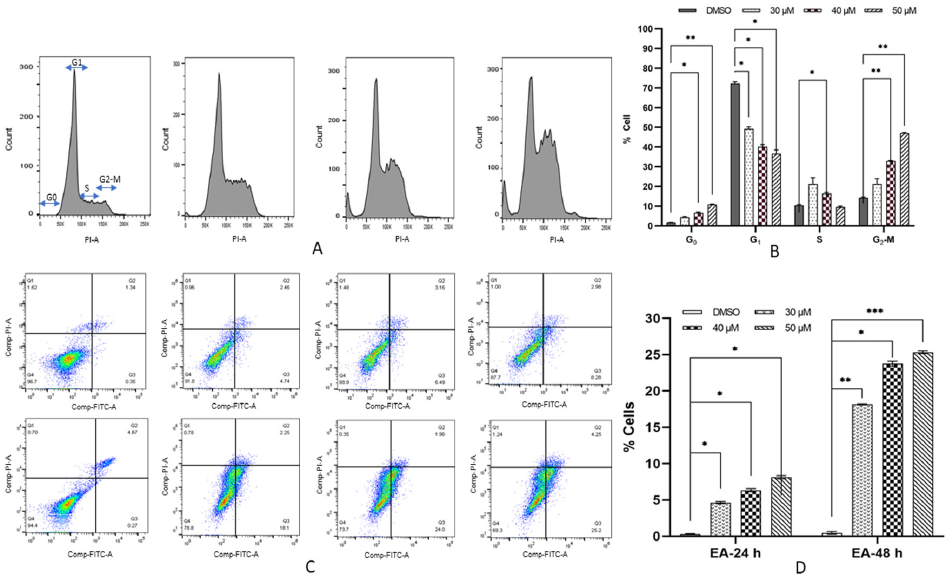
Figure 2. ( A ) Flow cytometry analysis: Analysis of DNA content of PI stained HeLa cells, treated with 30, 40 and 50 µM of kaempferol for 24 and 48 h, was compared with DMSO, which induced G2/M arrest cell cycle arrest with an increase in the sub-G0 apoptotic population. ( B ) Graphical rep- resentation of the cells’ distribution in different phases of the cell cycle at 48 h is expressed as a percentage. ( C ) Annexin V/PI double staining kaempferol-induced apoptosis in HeLa cells after treatment (30µM, 40µM and 50 µM) for 24 and 48 h in comparison with DMSO control. Representa- tive picture of dot plots showing different stages of apoptosis. Left lower quadrant (FITC-/PI-) = Viable cells, right lower quadrant (FITC+/PI-) = early apoptotic cells and right upper quadrant (FITC+/PI+) = late apoptotic cells. (D) Graph demonstrating % distribution of apoptotic cells in their respective quadrants. Early apoptotic cells proportions were increased at both time- and concentra- tion-dependent manner compared to control. * represents p < 0.05; ** = p < 0.01, *** p < 0.001. 3.4. Kaempferol Increases Early Apoptosis in HeLa Cells To ascertain whether G2/M cell cycle arrest is accompanied by apoptosis induction by kaempferol, Annexin V/PI double staining was employed. Treated HeLa cells at 20, 30 and 50 µM for 48 h exhibited an increase in the proportion of early apoptotic cells with an insignificant change in the proportion of post apoptotic cells. In contrast, the percentage of live cells showed a decreasing trend. Early apoptotic cell population was found to be increased from 0.35% to 4.74%, 6.49% and 8.26% at 30, 40 and 50 µM in 24 h, whereas in 48 h treatment, it raised to 18.1%, 24% and 25.2%, respectively. Therefore, Annexin/PI staining clearly established the apoptosis-inducing property of kaempferol in HeLa cells (Figure 2C,D). 3.5. Kaempferol Modulates Expression of Various Genes Involved in Cell Cycle Regulation and Signalling Pathways Overexpression of MAPK and AKT/mTOR leads to uncontrolled cell proliferation and survival, consequently causing transformation of cells. Kaempferol treatment (30 and 50 µM for 48 h) limits cancer cell proliferation by downregulating MAPK and AKT/mTOR pathways at the transcript level . Expression of various MAPK pathway genes was consid- erably downregulated, such as MAPK1, MAK14, MAP2K1, MAP2K3, MAP2K5, MAP2K6, MYC and ELK 1. Further, the transcript-level expression of PI3K / AKT/mTOR genes, such as AKT2, MTOR, PIK3C2B, PIK3CA, PIK3CB, PIK3CD, was also found to be significantly downregulated. However, expression of various tumor suppressor genes, such as PTPRR, ATM, ATR, FOXO 1, and FOXO 3, was upregulated.